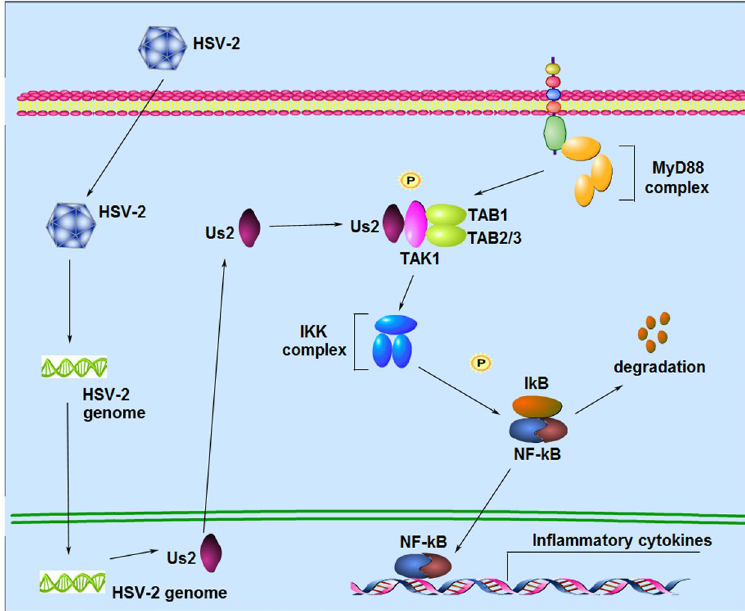
Figure 6. Schematic model of the role of Us2 in the regulation of NF- κ B signaling. During HSV-2 infection, Us2 interacts with the kinase TAK1, which leads to activation of the IKK complex. The activated IKK complex induces phosphorylation and degradation of I κ B, leading to translocation of NF- κ B from the cytoplasm to the nucleus for the subsequent production of cytokines and